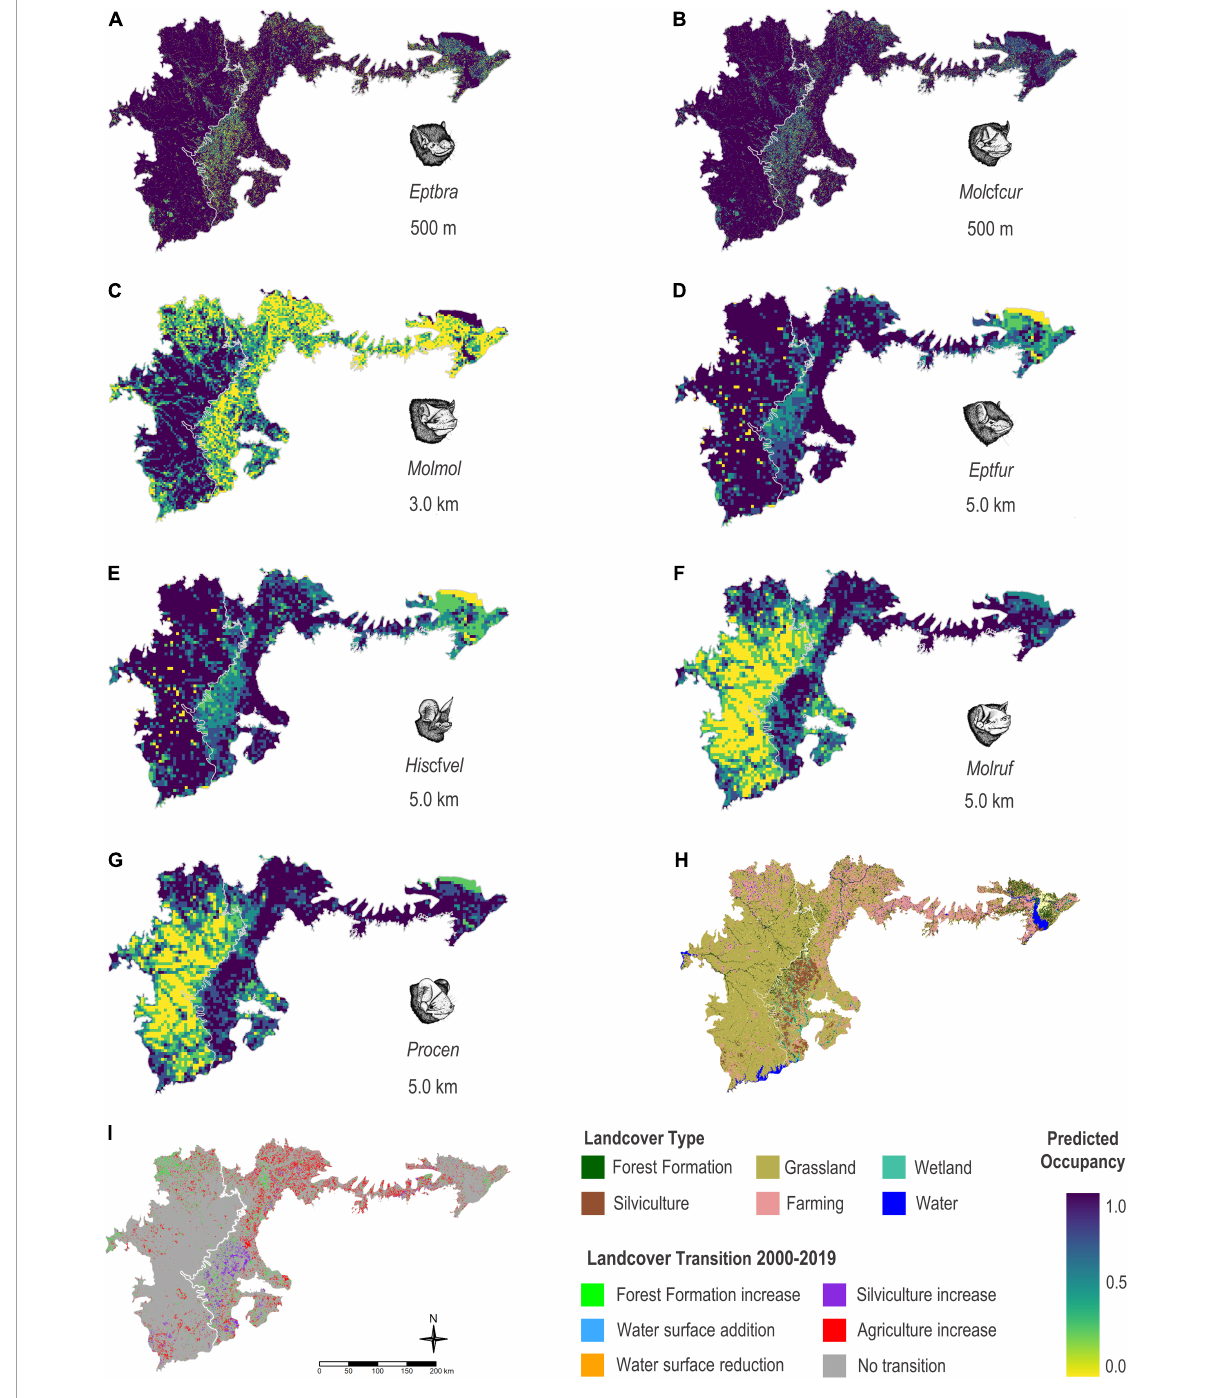
FIGURE4 Estimated occupancy for nine species of bats for the area occupied by two main phytophysiognomies present in the Brazilian and Uruguayan portion of the Uruguayan Savanna – shallow soil fields and mixed stands of andropogon grass, based on the modelling results using the bat acoustic data gathered in the Brazilian Pampa during spring and summer 2019 and 2020. (A) Eptesicus brasiliensis ( Eptbra ), (B) Molossus cf. currentium ( Mol cf cur ), (C) Molossus molossus ( Molmol ), (D) Eptesicus furinalis ( Eptfur ), (E) Histiotus cf. velatus ( His cf vel ), (F) Molossus rufus ( Molruf ), (G) Promops centralis ( Procen ), (H) map showing landcover types, and (I) map showing the land use and land cover transition between the years 2000 and